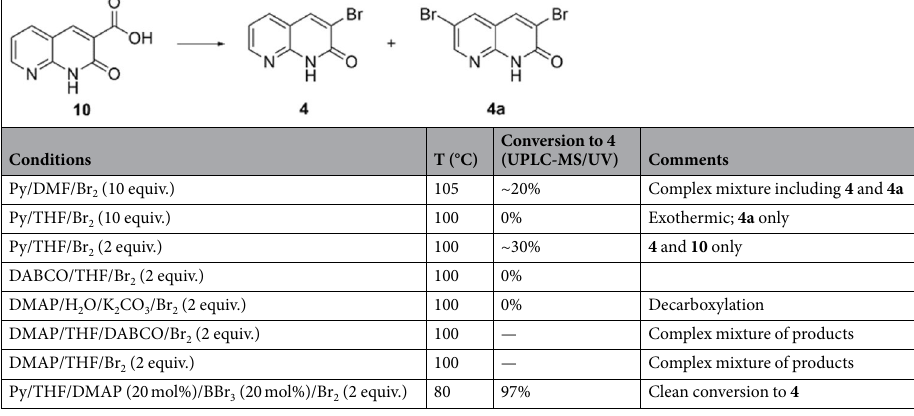
Table 1. Summary of the enhancement